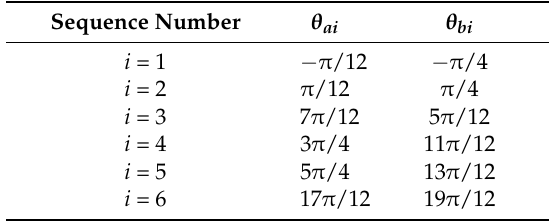
Table 2. Angle parameters of the six-axis